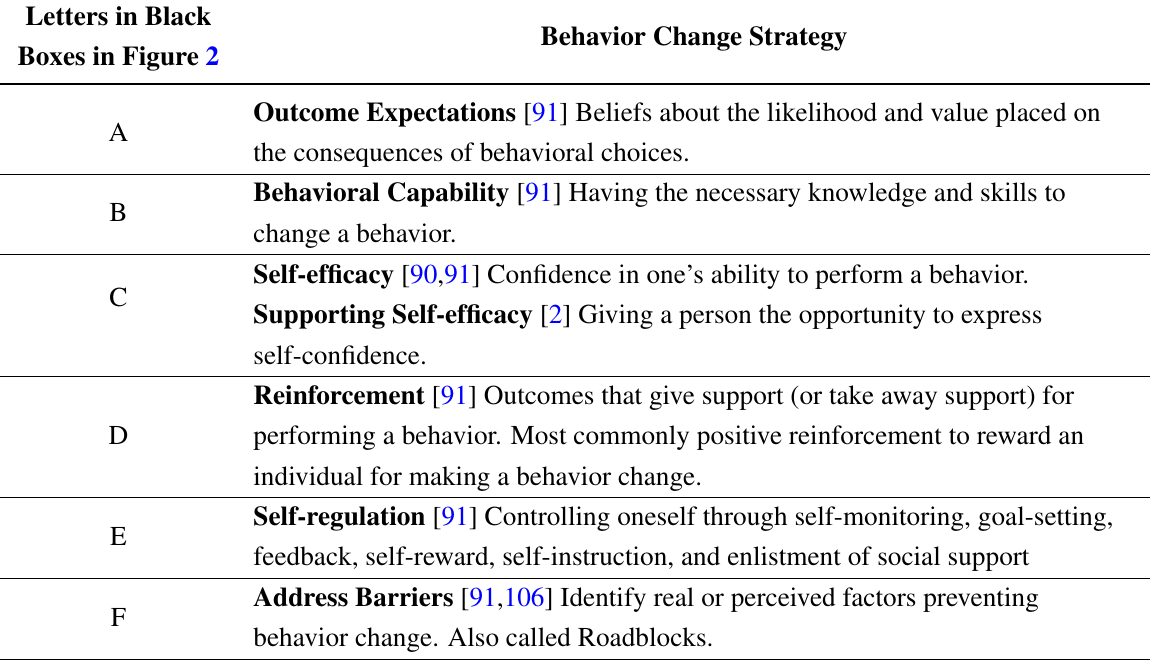
Table 3. Behavior Change and Motivational Interviewing Strategies Used in HomeStyles Guides. Letters in the left column correspond to the letters in black boxes in Figure